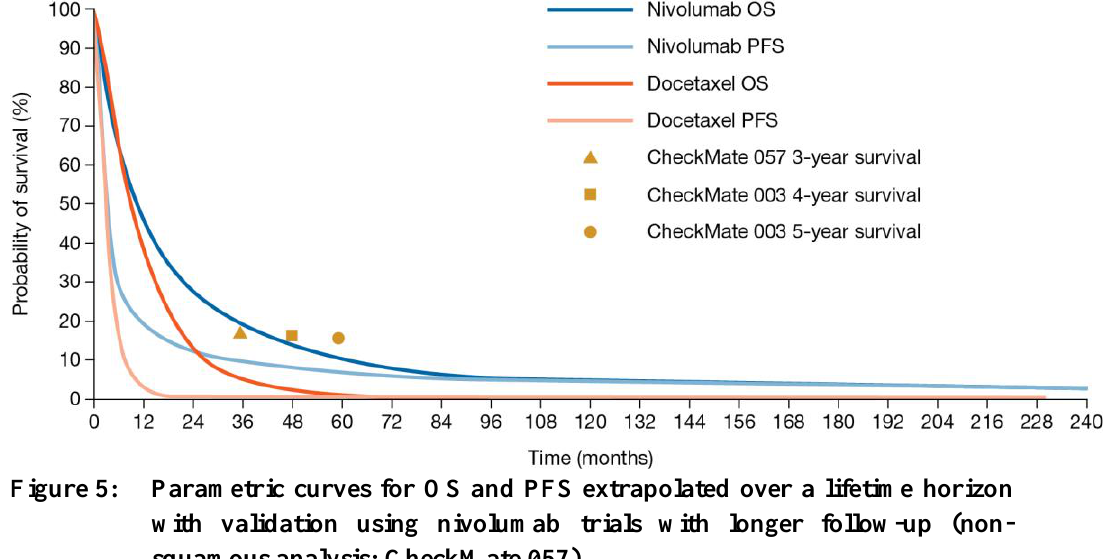
Figure 5: Parametric curves for OS and PFS extrapolated over a lifetime horizon with validation using nivolumab trials with longer follow-up (non- squamous analysis; CheckMate 057) OS = overall survival; PFS = progression-free survival. Table 2: Mean EQ-5D-3L values from the non-squamous analysis (CheckMate 057) by treatment and health state Treatment Country Progression-free Progressed disease (reference for tariff) health state utility health state utility Mean (95% CI) Mean (95% CI) Nivolumab UK (Dolan 1997) 0.761 (0.747, 0.774) 0.716 (0.687, 0.744) Sweden (Burstrom et al. 2014) 0.853 (0.846, 0.859) 0.830 (0.817, 0.844) Docetaxel UK (Dolan 1997) 0.716 (0.703, 0.730) 0.638 (0.597, 0.678) Sweden (Burstrom et al. 2014) 0.825 (0.819, 0.832) 0.795 (0.778,